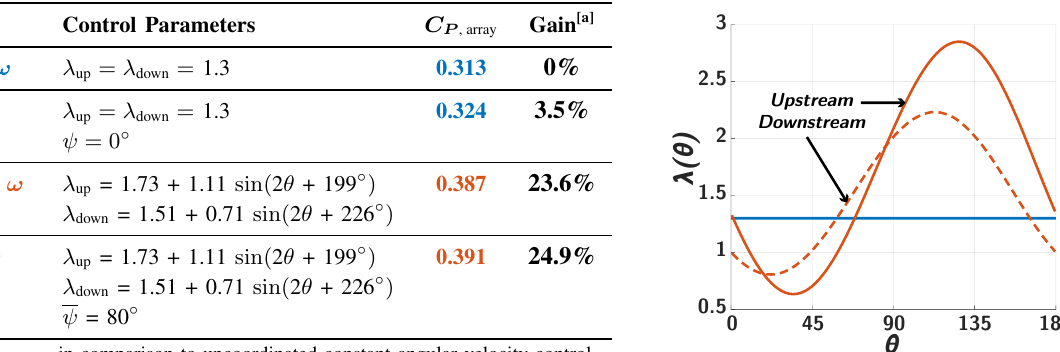
Fig. 8. A summary of results for the coordinated intracylce angular velocity control experiment. For uncoordinated constant angular velocity control, both turbines are operated at λ = 1 . 3 . Via a sweep of tip-speed ratios of both turbine (see Fig. 9), this was found to result in peak array performance. Uncoordinated control efficiency was calculated as the mean performance over all coordinated control blade position differences. The peak array performance for coordinated constant angular velocity control is given in the second row. Optimized angular velocity profiles for coordinated control are shown to the right, corresponding to the third and fourth rows. Like the constant angular velocity results, the uncoordinated and coordinated sinusoidal angular velocity results are given as the mean and peak array performance for a sweep of mean blade position difference, ψ .